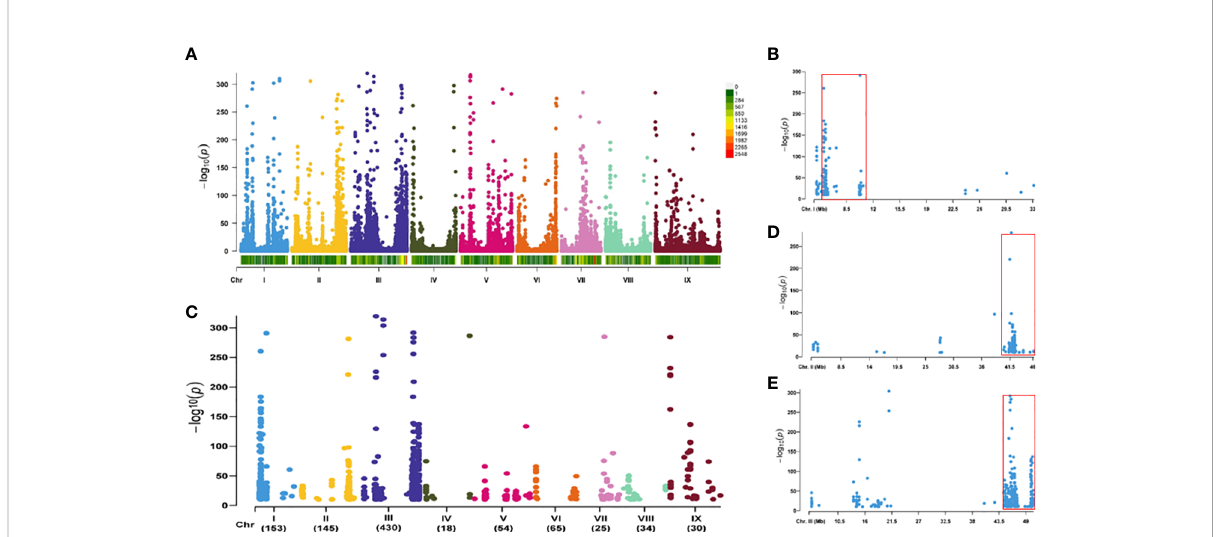
FIGURE 2 SNPs identi fi ed by the BSR-Seq analysis based on the RILs of Yugu 5 × Jigu 31 cross with yellow and brown hull colors. (A) distribution of all SNPs generated by RNA sequencing of the two bulks for the RNA samples of the RILs yellow and brown hull colors (Bulk-Y and Bulk-B, respectively) on different foxtail millet chromosomes. (B) distribution of SNP variants between Bulk-Y and Bulk-B potentially associated with hull color produced by BSR-Seq analysis on different foxtail millet chromosomes. (C – E) , SNP variants on chromosomes 1, 2, and 3. The signi fi cantly enriched genomic intervals of the candidate SNPs for hull color are marked with red boxes.